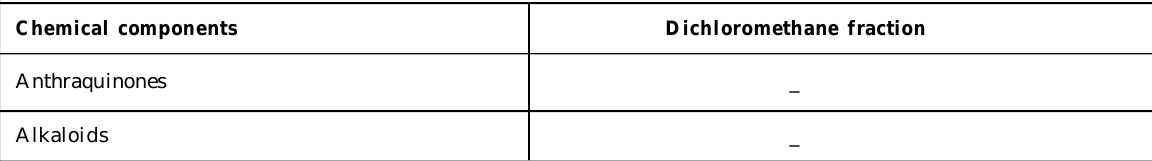
Table 4: Phytochemical screening of dichloromethane fraction of an ethanol extract of stem bark of Piliostigma reticulatum Chemical components Dichloromethane fraction